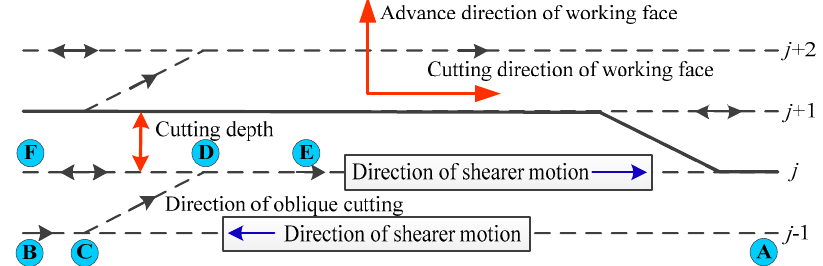
Figure 2. Schematic diagram of the shearer terminal oblique cutting.